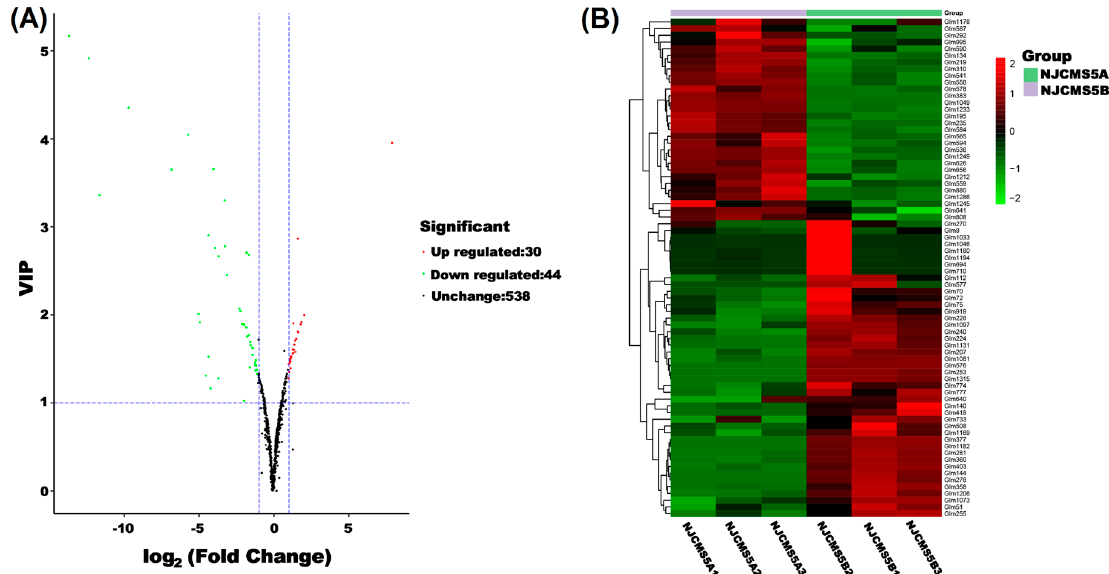
Figure 3. Volcano plot and heat map analysis of differential metabolites between NJCMS5A and NJCMS5B. ( A ) Volcano plot of differential metabolites between NJCMS5A and NJCMS5B. Red point, green point, and black point indicate the metabolites that were significantly up-regulated, significantly down-regulated, and non-significantly different, respectively; ( B ) Heat map analysis of 74 differential metabolites between NJCMS5A and NJCMS5B. The values of differential metabolites were normalized and shown as a color scale. The high and low metabolite levels were represented as reddish and greenish scales, respectively.